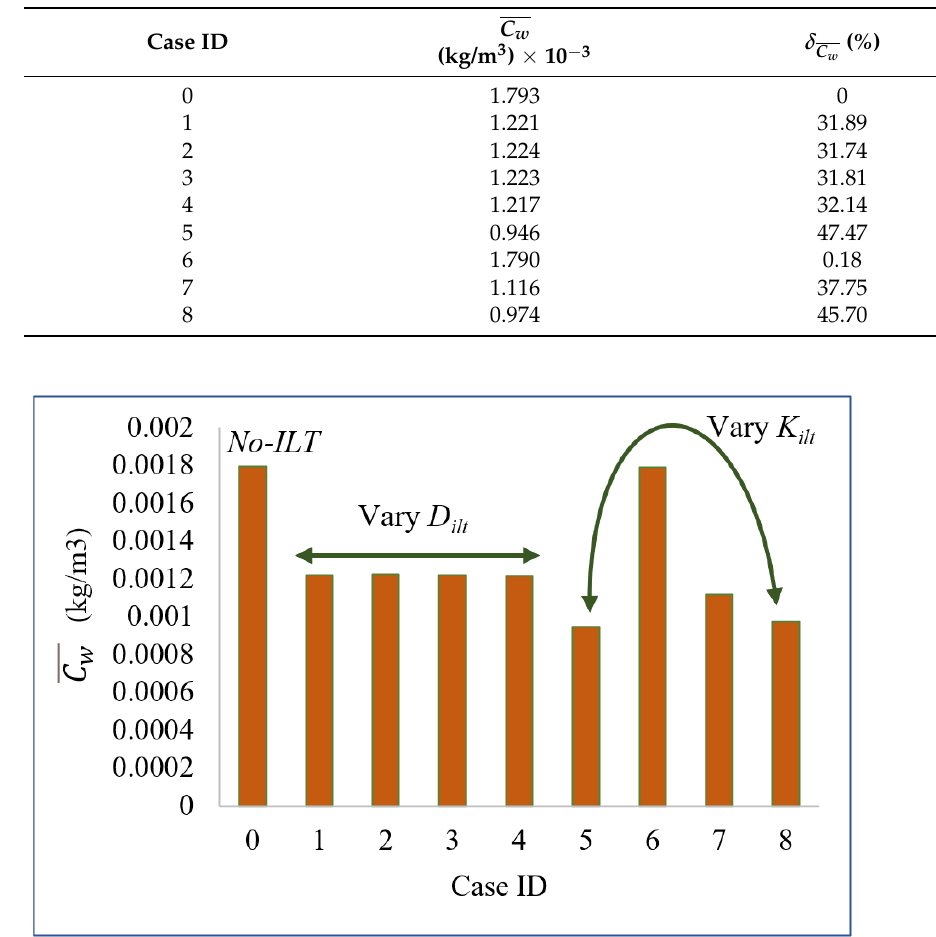
Figure 5. Volumetric average of oxygen concentration in the arterial wall for the nine simulated cases based on the information provided in Table 3. Case 0 is without ILT.